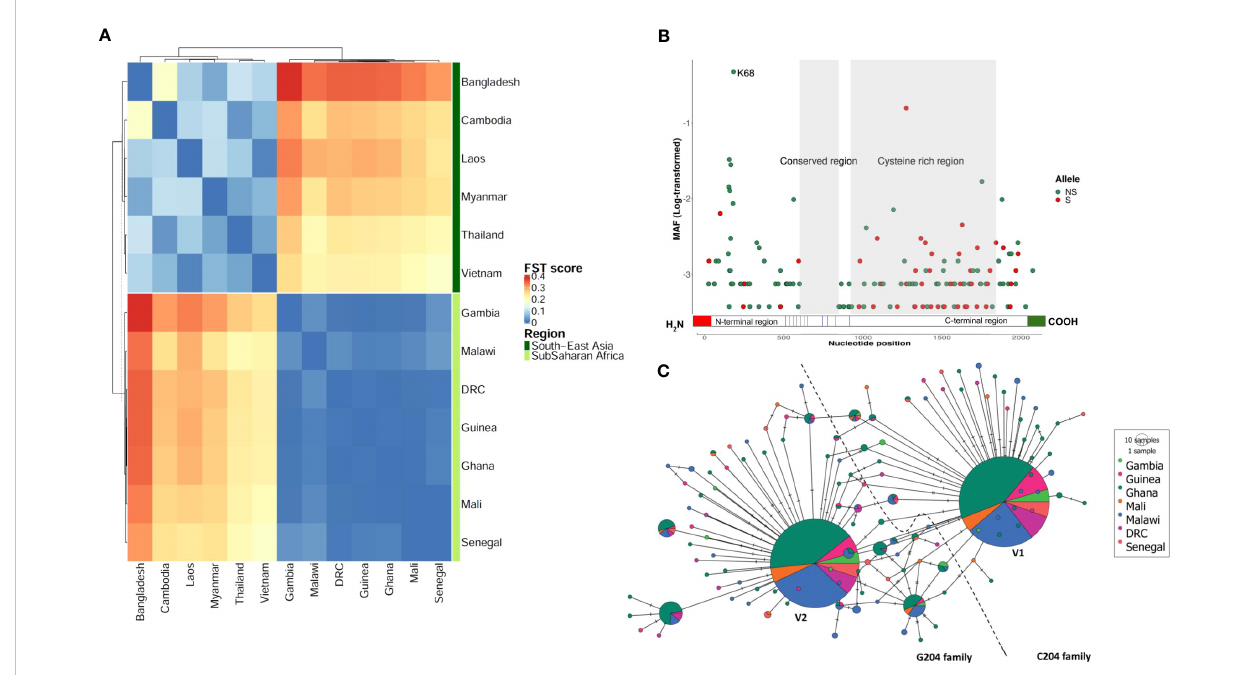
FIGURE 1 Sequence diversity of ARMA. (A) Population differentiation between West and Central African and South-East Asian parasite populations. The heatmap shows all FST values after a pairwise analysis (N= 2,317). (B) Minor allele frequencies along the gene. Each dot represents a unique allele which is either synonymous (S) or nonsynonymous (SN). The minor allele frequencies (MAF) are shown as log-transformed values. Only two alleles had a frequency above 10%. The conserved region contained no SNPs. N68K is the most frequent polymorphism observed. (C) Haplotype network based on the hamming distance between gene variants in West and Central Africa. Each pie-chart represents a unique haplotype based on nonsynonymous SNPs. Colors code for geographical locations of the samples. Pie-chart size is proportional to haplotype frequency in the population. The lines (branches) between haplotypes represent ancestral relationships, i.e., the degree of relatedness. The two equally dominant haplotypes (largest pie-charts) differ by a single nucleotide at position 204. The dashed line separates the C204 and G204 families. The haplotype found in the P. falciparum 3D7 strain belongs to the C204 family. DRC, Democratic Republic of